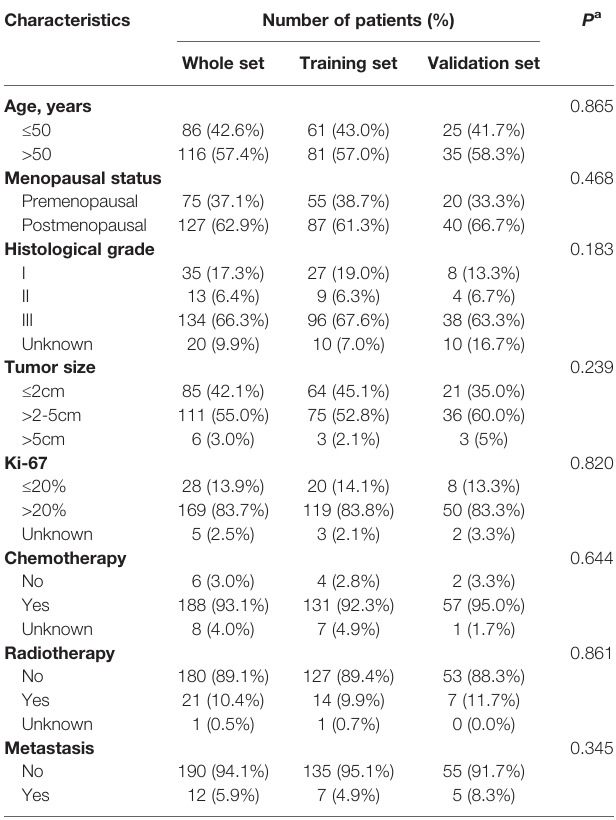
TABLE 1 | Clinicopathological characteristics of patients and their tumors.